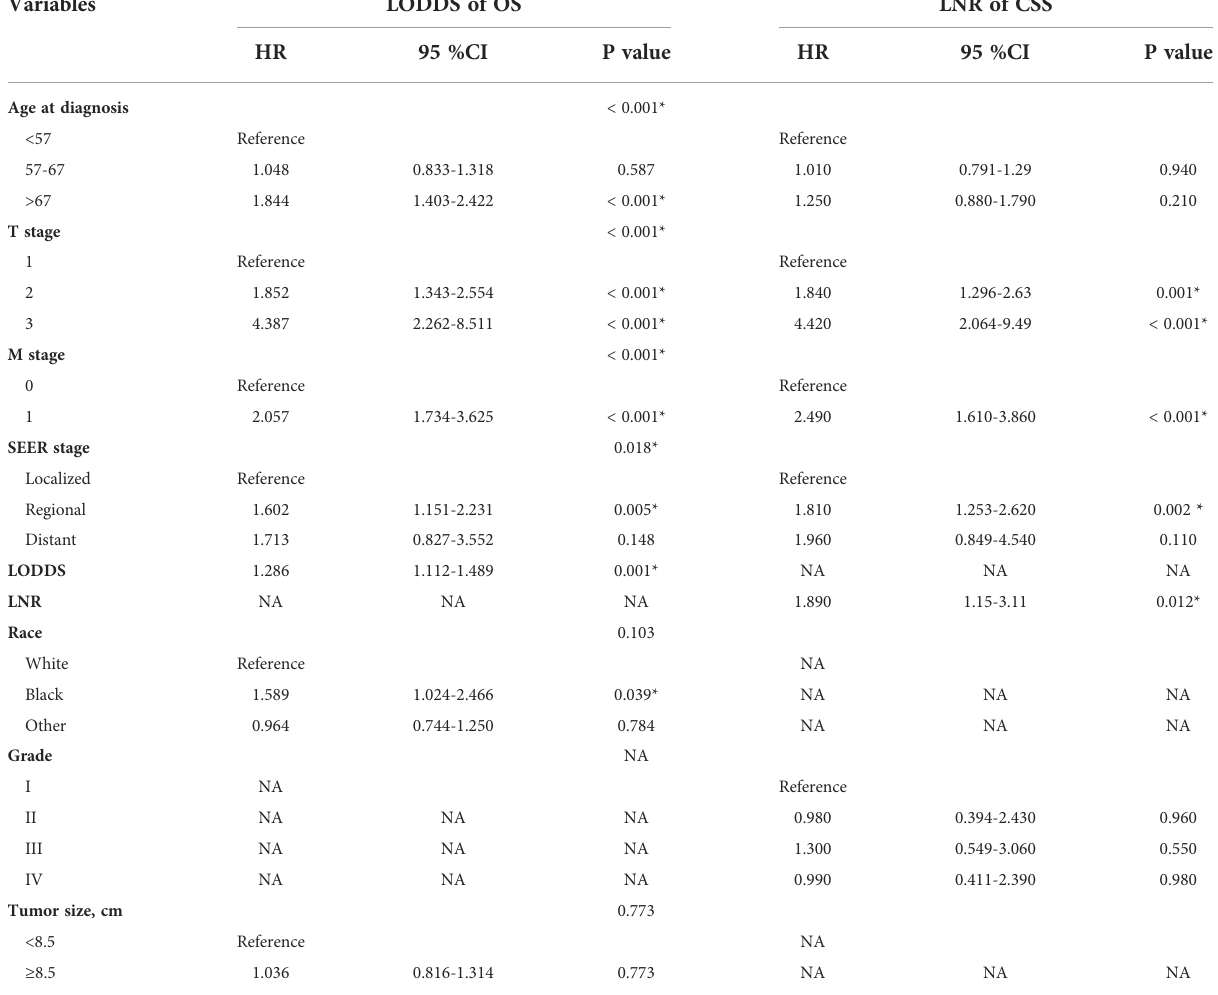
TABLE 3 Multivariate analysis of continuous LODDS for OS and continuous LNR for